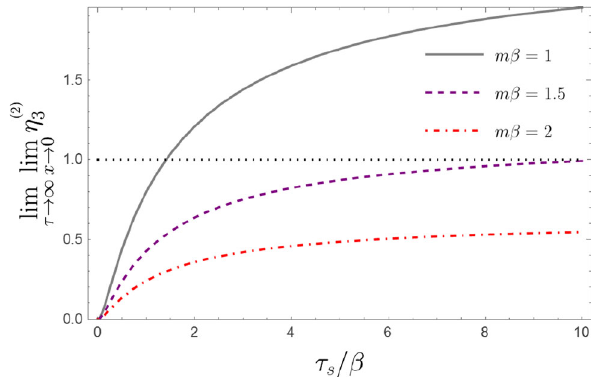
Fig. 7 Vacuum versus thermal dominance near the wall for different valuesof τ s /β and m β ,with D = 3.Forhighvaluesofthefieldmassthe vacuum contribution always dominate, independently of the switching time